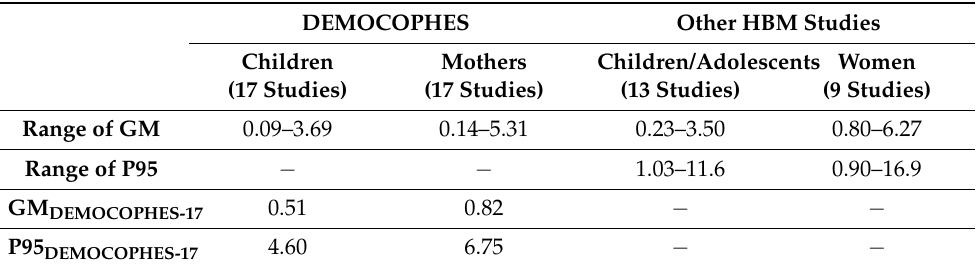
Table 2. Range of geometric means (GM) and/or 95th percentiles (P95) of MeHg and/or Hg con- centrations in blood ( µ g/L) (hair values are expressed as blood concentration using hair to blood ratio of 280:1) from European HBM studies and GM and P95 values for the whole DEMOCOPHES-17 reference study. DEMOCOPHES Other HBM